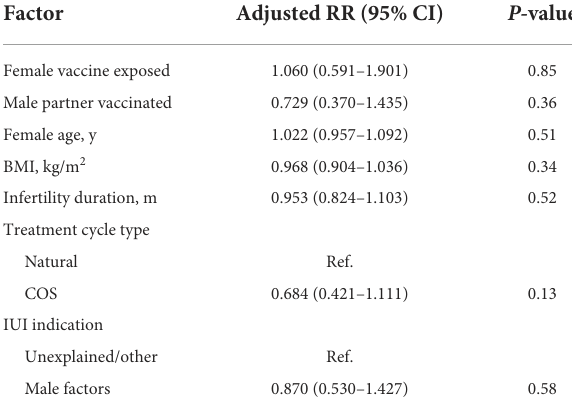
TABLE 6 Adjusted binary logistic regression model for predictors of ongoing pregnancy of artificial insemination with husband semen (725 cycles in 492 couples) using generalized estimating